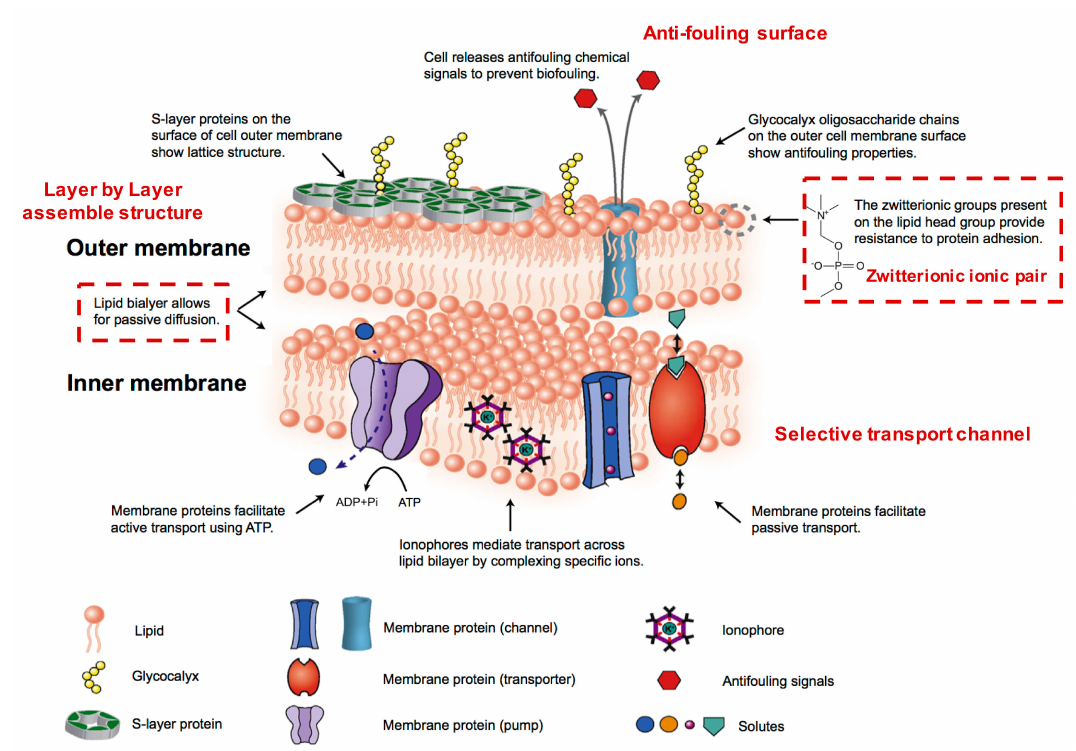
Figure 1. Biological membrane separation and antifouling strategies for an example of a gram-negative bacterial organism. Reproduced with permission from Reference